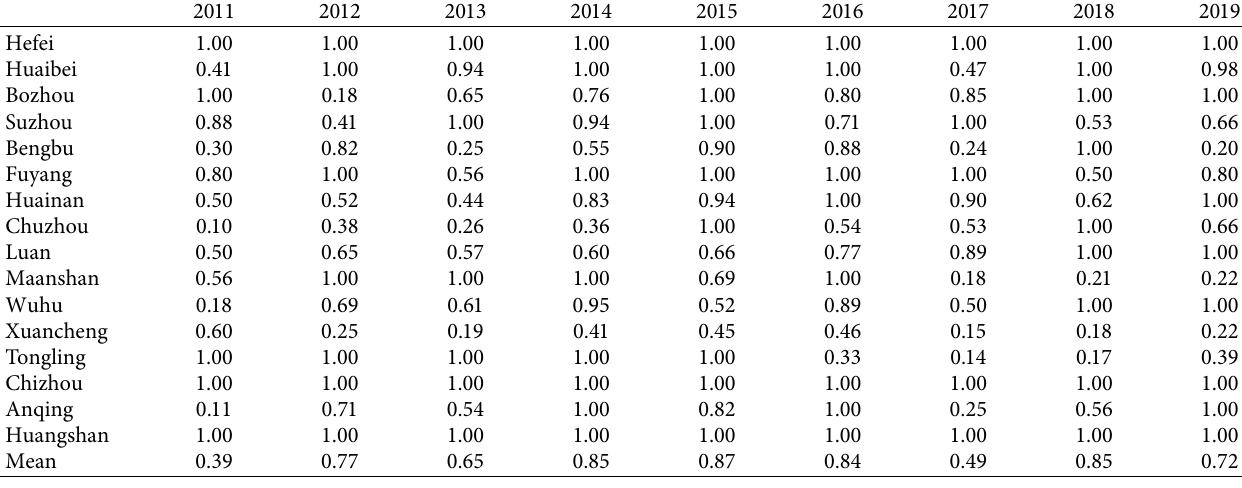
Table 3: Results of technical efficiency on inbound tourism.